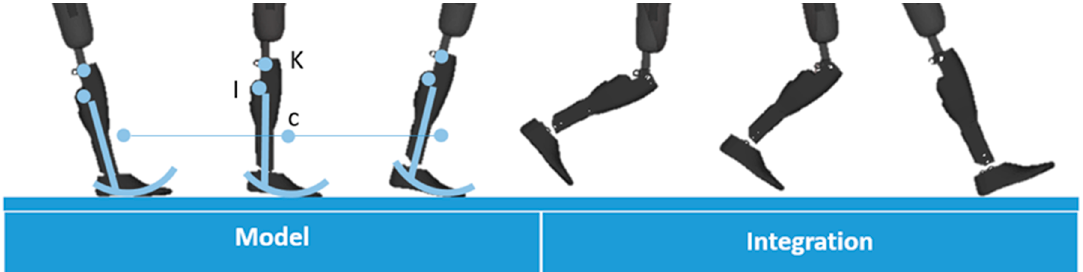
Figure 2. Computation strategy and illustration of the model used. C is the center of the curved arc foot model, K is the center of the knee, I is the center of the IMU frame.